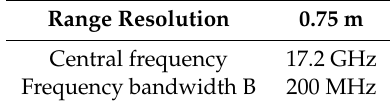
Table 2. Technical Specifications of IBIS-F / L